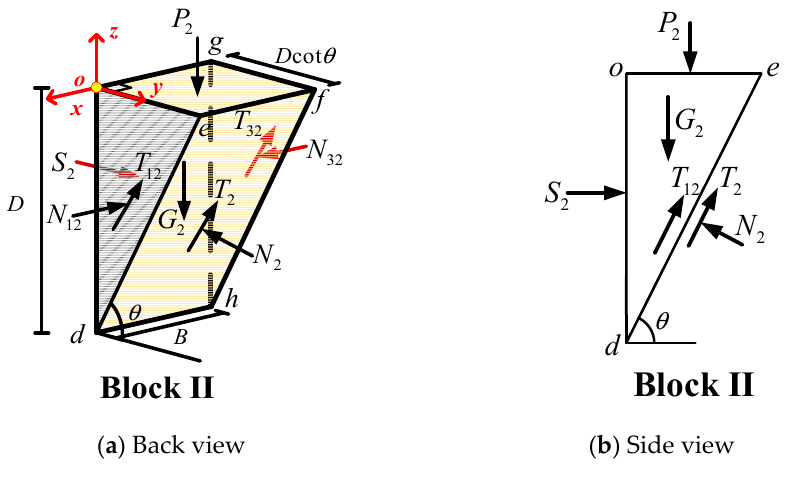
Figure 6. Forces applied on block II.